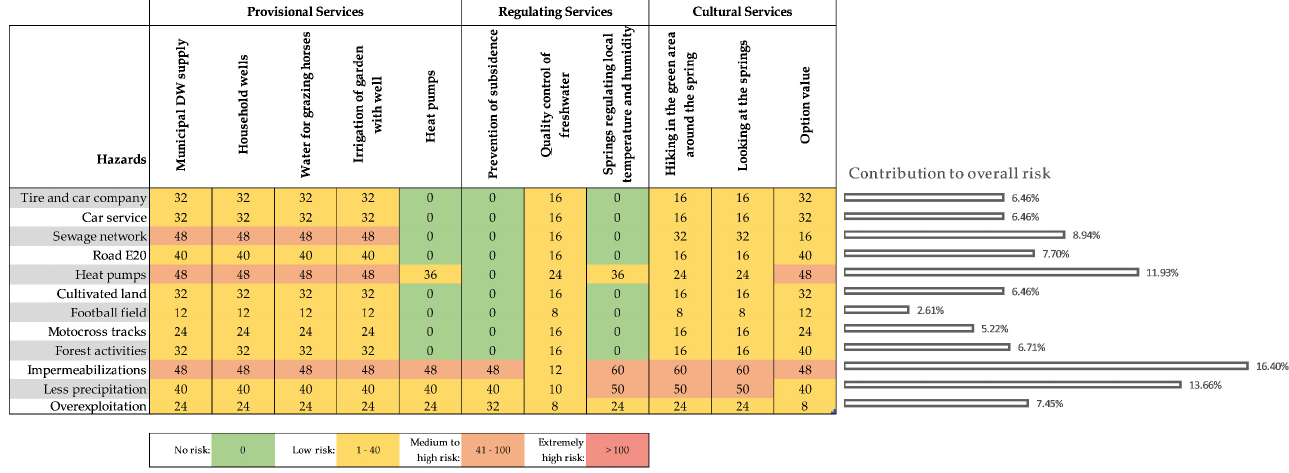
Figure 7. Assessment matrix contrasting hazard sources and their impact on water system services. Numbers from 0 (minimum risk score) to 125 (maximum risk score possible) in the matrix represent the calculated risk score for each hazard-service pair. The bar chart on the right indicates the contribution of each hazard source to the overall risk.